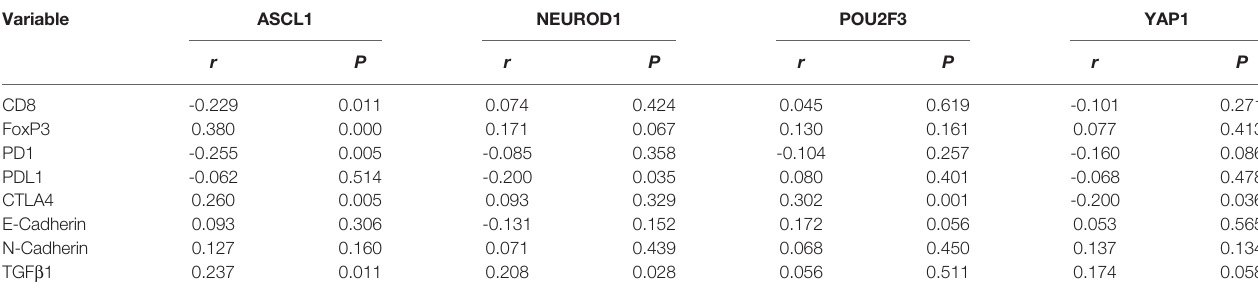
TABLE 5 | The expression correlation of immunologic indicators in tumors positive for single subtype marker of primary small cell lung cancer.